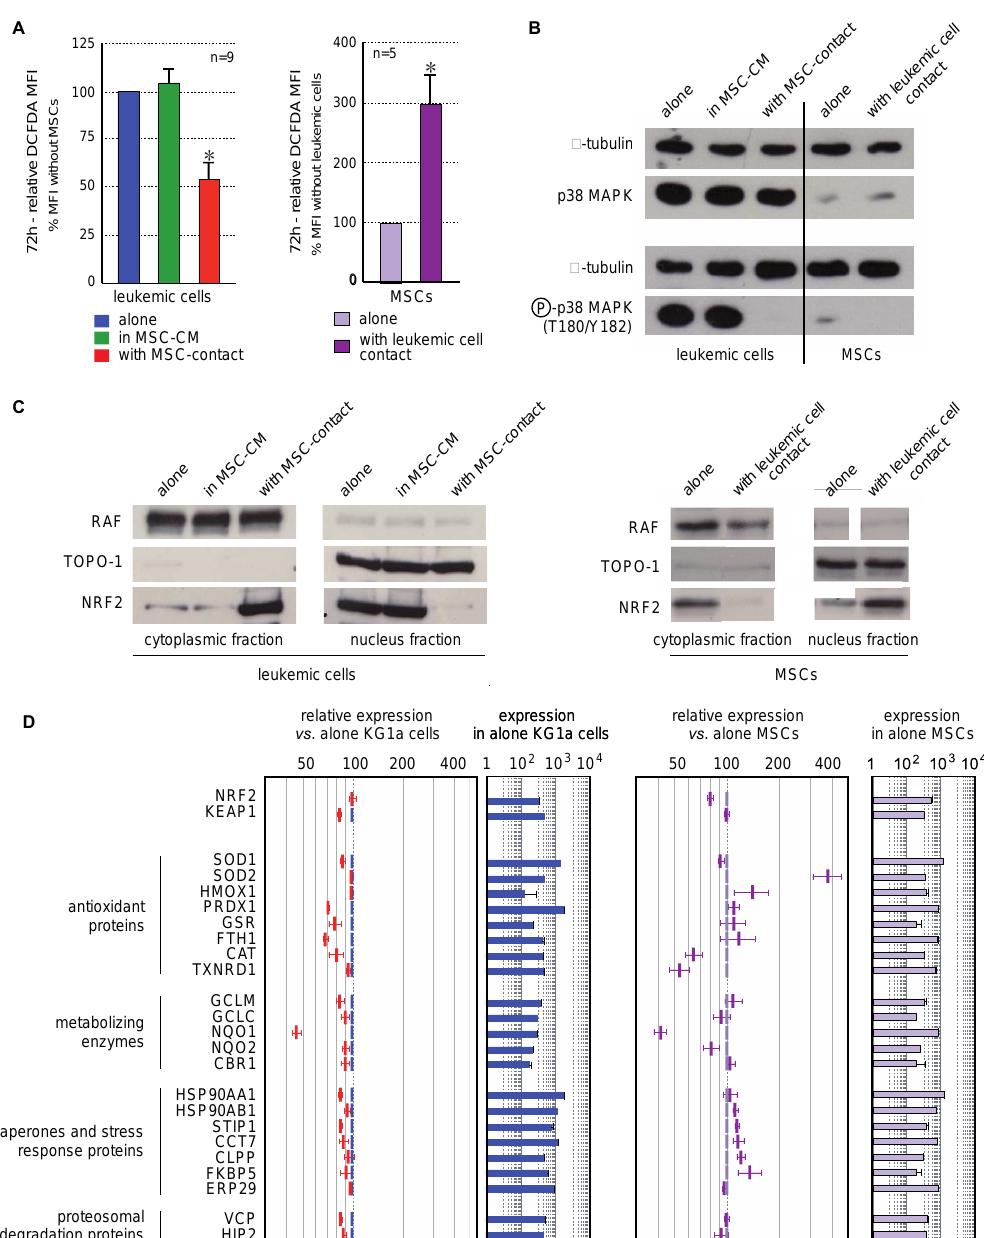
Figure 4. Interaction between leukemic cells and MSCs induces opposite oxidative metabolism and Nrf2 pathway modifications in both cell types. ( A ) Intracellular ROS level was analyzed by flow cytometry after CM-H 2 DCFDA staining in leukemic cells cultured alone (blue), with MSC-CM (green), or with MSCs (red) as well as in MSCs cultured alone (violet) or cocultured with KG1a cells (dark violet) for 72h ( n = 5 – 9). ( B ) The expression and activation of p38MAPK were analyzed by Western blot in KG1a cultured alone, with MSC-CM or cocultured as well as in MSCs alone or cocultured with leukemic cells ( n = 3); alpha-tubulin was used as loading control. ( C ) Nrf2 subcellular localization was analyzed by Western blot in the cytoplasmic and nuclear fractions of leukemic cells (left) or MSCs (right). RAF and TOPO-1 were used as loading controls and purity indicators of the cytoplasmic and nuclear fractions, respectively. ( D ) Nrf2 target genes expression was evaluated by transcriptomic analysis and is presented as relative expression vs. KG1a cells or MSCs alone ( n = 3). * p < 0.05.